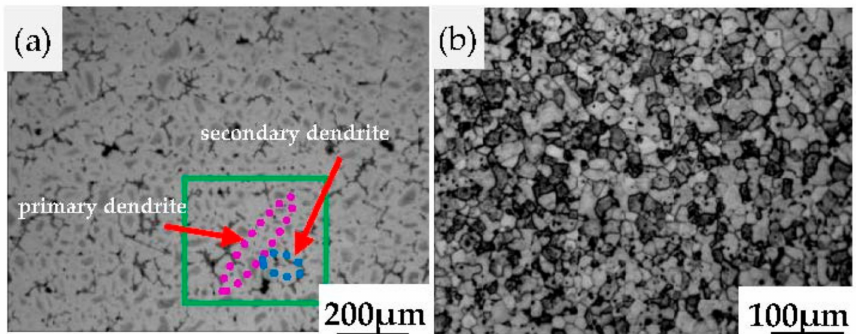
Figure 3. Optical micrographs (OM) of the samples showing the effect of Fe, Co on grain refinement.